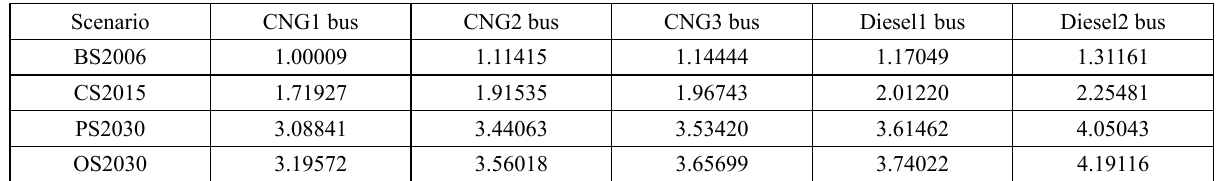
Table 6. Average external costs of CO 2 emissions per 100 bus-kms for different bus concepts according to various scenarios [€/100 bus-kms]